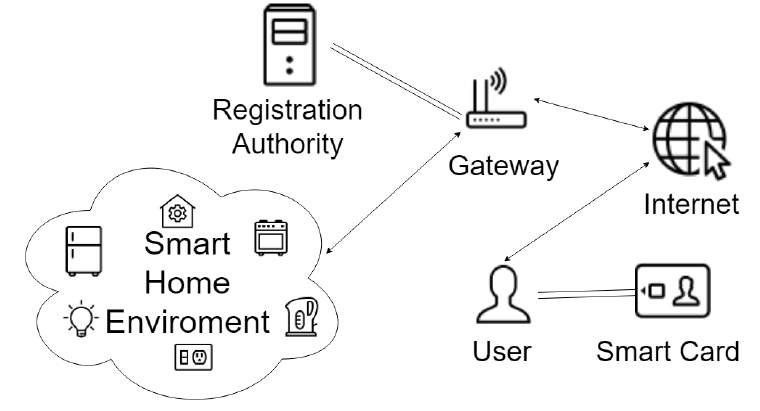
Figure 1. A typical smart home architecture (adapted from